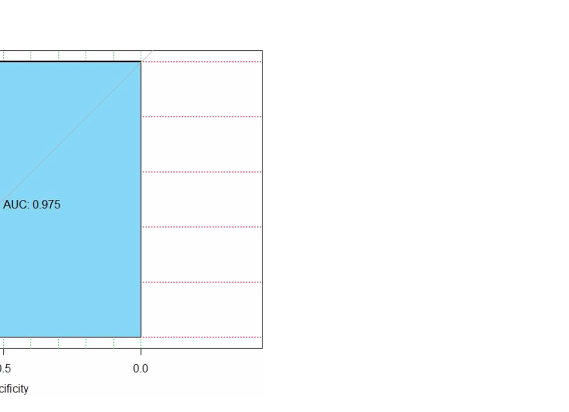
FIGURE 4 The area under the curve (AUC) of the random forest algorithm for the established